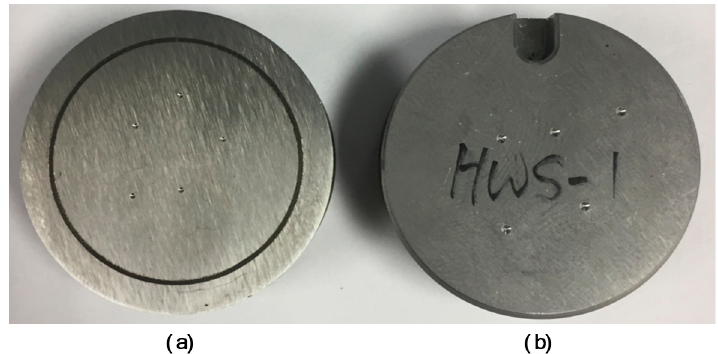
Figure 5. State of the specimen after the hardness test: ( a ) HWS AM material part of the wear specimen; ( b ) D2 substrate material part of the wear specimen.